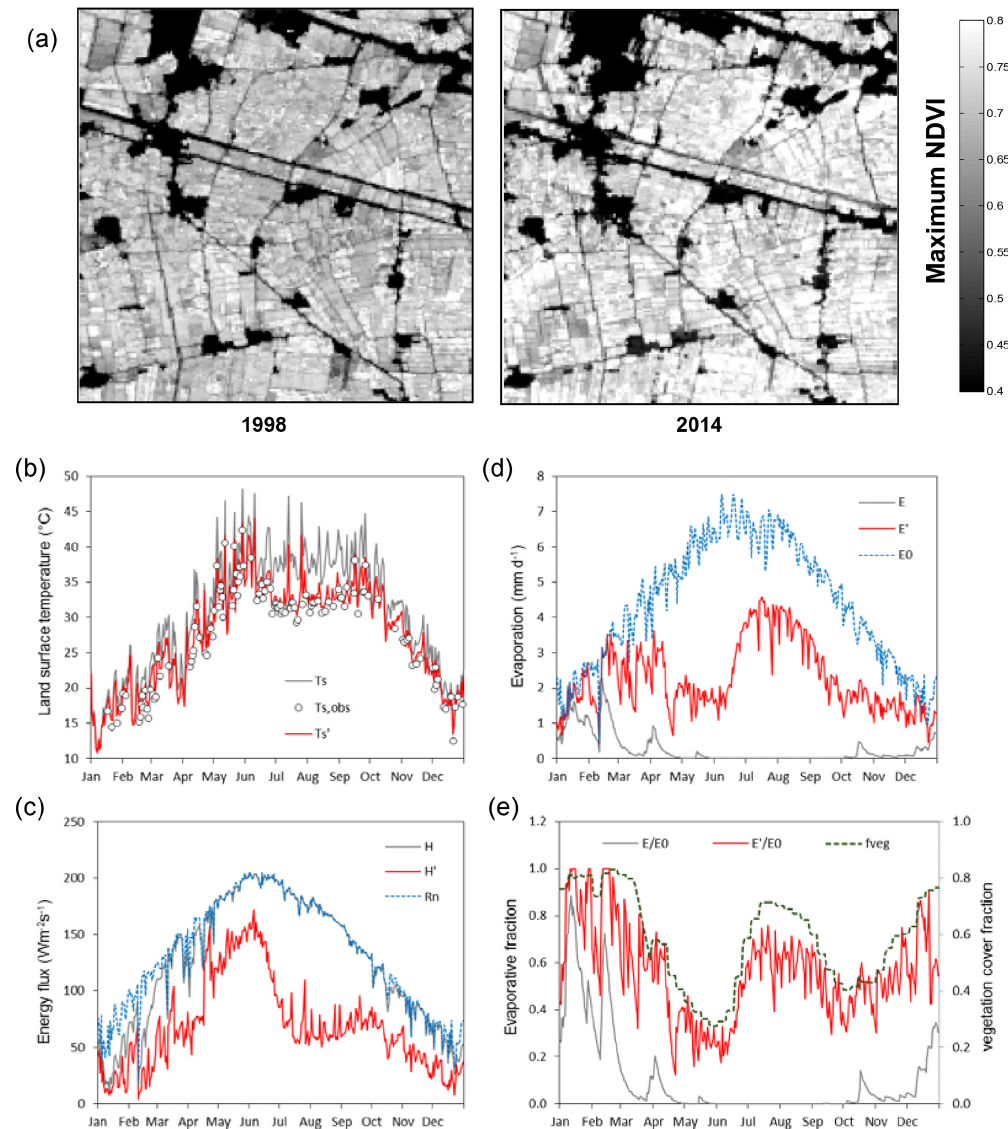
Figure 2. Illustration of method to assimilate MODIS land surface temperature observations. Data shown are for 2002, for a 0.05 ◦ grid cell in the Nile River delta, Egypt (centred 31.075 ◦ N, 30.325 ◦ E) and panels represent the following: (a) Maximum normalized difference vegetation index (NDVI) derived from Landsat imagery provided by Google Earth Engine, suggesting that effectively 81% and 80% of the grid cell was cropped in 1998 and 2014, respectively; (b) Land surface temperature, with background ( T s , grey line), observed ( T s,obs , circles) and analysis ( T (cid:48) s , red line) estimates for the grid cell with average bias across the 15 ◦ window removed; (c) Sensible heat flux, with background ( H , grey) and analysis ( H (cid:48) , red) estimates along with net radiation ( R n , blue); (d) Evaporation, with background ( E , grey) and analysis ( E (cid:48) , red) estimates and potential evaporation ( E 0 , blue) and (e) Evaporative fraction, with background ( E /E 0 , grey) and analysis ( E (cid:48) /E 0 , red) and, for comparison, vegetation cover fraction derived from MODIS NDVI ( f veg ,